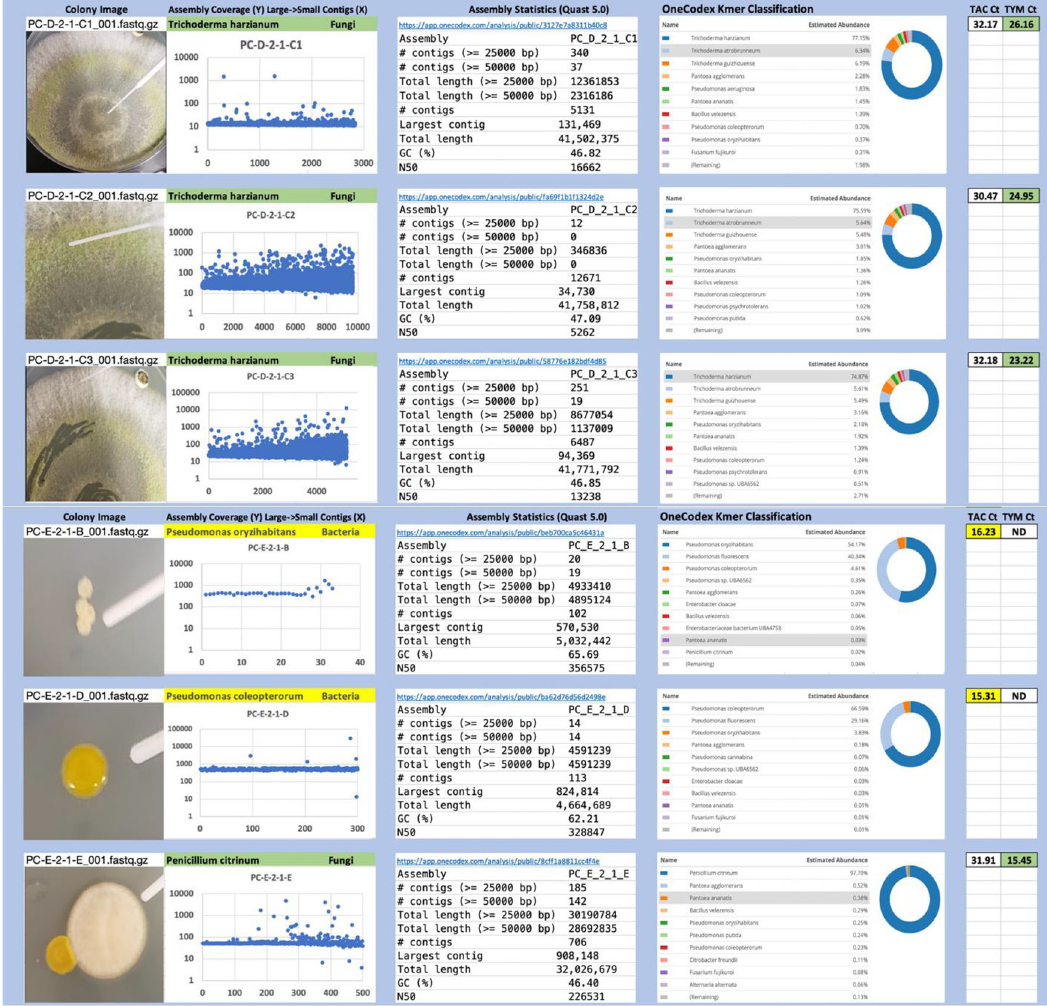
results. As a comparison, quantitative PCR demonstrated over 10 Cts (1024 fold) differences between the TYM and TAC signals on fungal colonies. The majority of the residual TAC signal being observed in fungi can be normalized and discounted with the background E. coli TLP DNA signal measured in blank